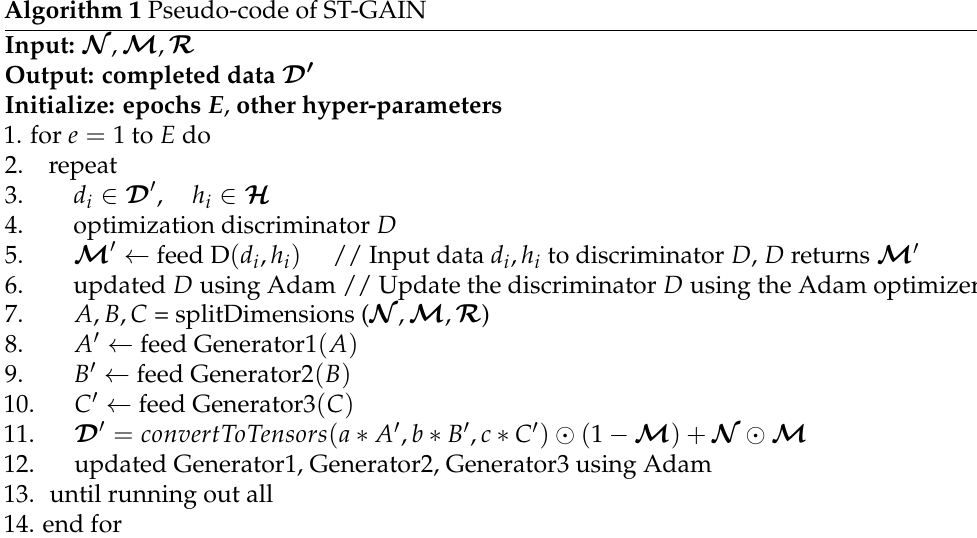
Algorithm 1 Pseudo-code of